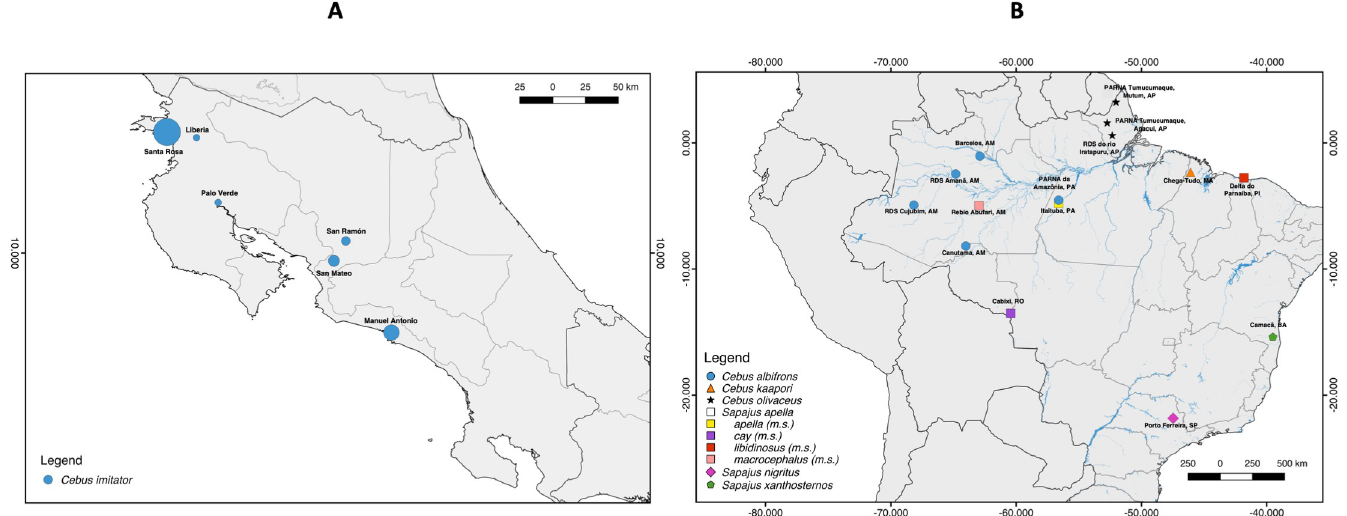
Fig 1. Sampling localities for capuchin species. (A) Cebus imitator sampling localities in Costa Rica. Circle size is proportionate to the number of individuals sampled at each location. (B) Sampling localities for the remaining cebine species evaluated in this study from South America. The legend shows the species demarcated by each symbol. “m.s” indicates morphospecies of Sapajus apella sensu lato .